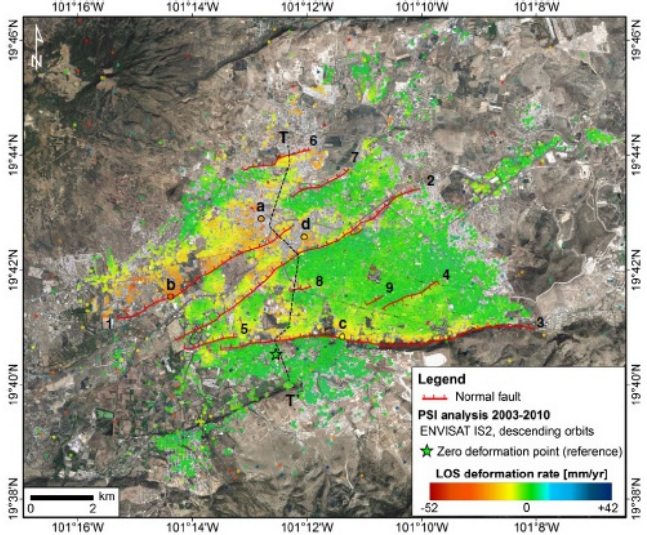
Figure 7. Vertical deformation rate in Morelia between 2003–2010 using PSI analysis of ENVISAT images [119]. images